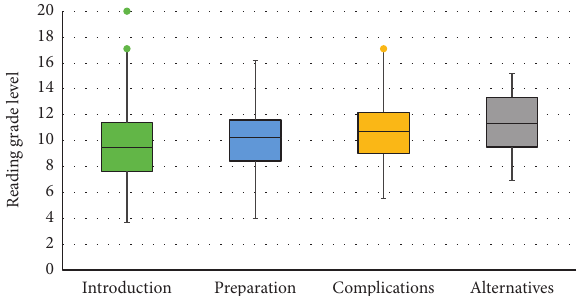
Figure 6: Box and whisker plot analysis of the readability of each subsection. Introduction had a median of 9.5 (3.7–20), preparation had a median of 10.3 (4–16.2), complications had a median of 10.7 (5.5–17.1), and finally alternatives had a median of 11.4